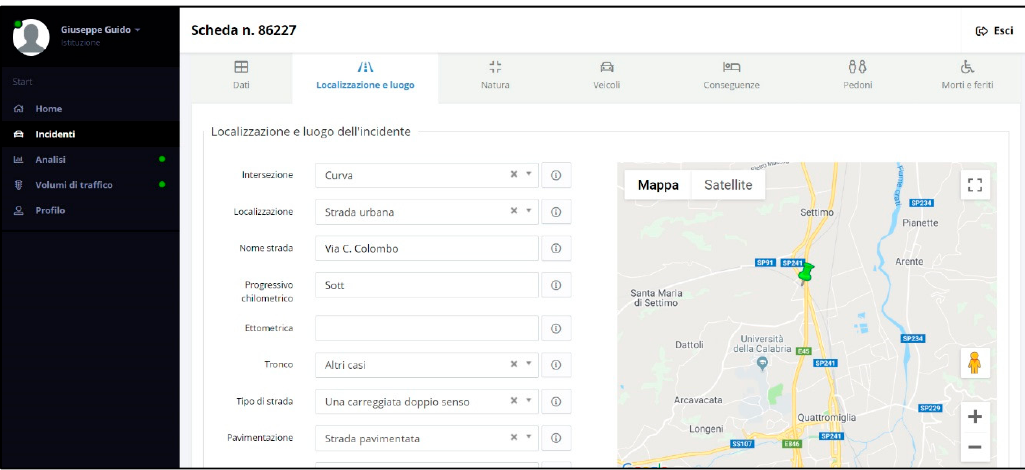
Figure 2. Sample of accident information report from CRISC website.